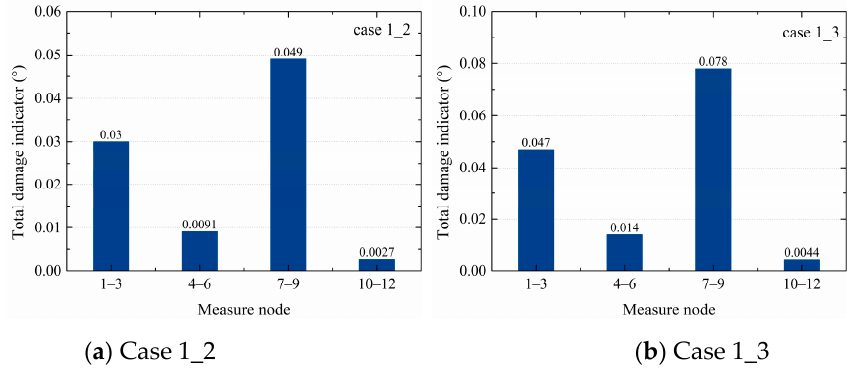
Figure 8. Total damage indicators of cases 1_2 and 1_3 from the TVSR models.